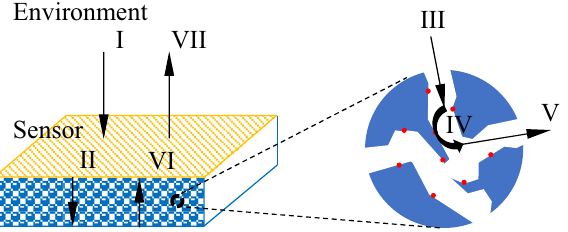
Figure 1. Mass transfer model of the sensor surface reaction. I: The measured substance transferred from the environment to the sensor surface; II: The measured substance diffuses from the through-hole of the sensor to the internal surface of the sensor; III: The measured substance Adsorb on the sensor surface; IV: The measured substance reacts with the surface substance; V: The reacted substance desorbed from the sensor surface; VI: The reaction product diffuses from the through-hole of the sensor to the sensor surface; VII: The product moves from the sensor surface to the